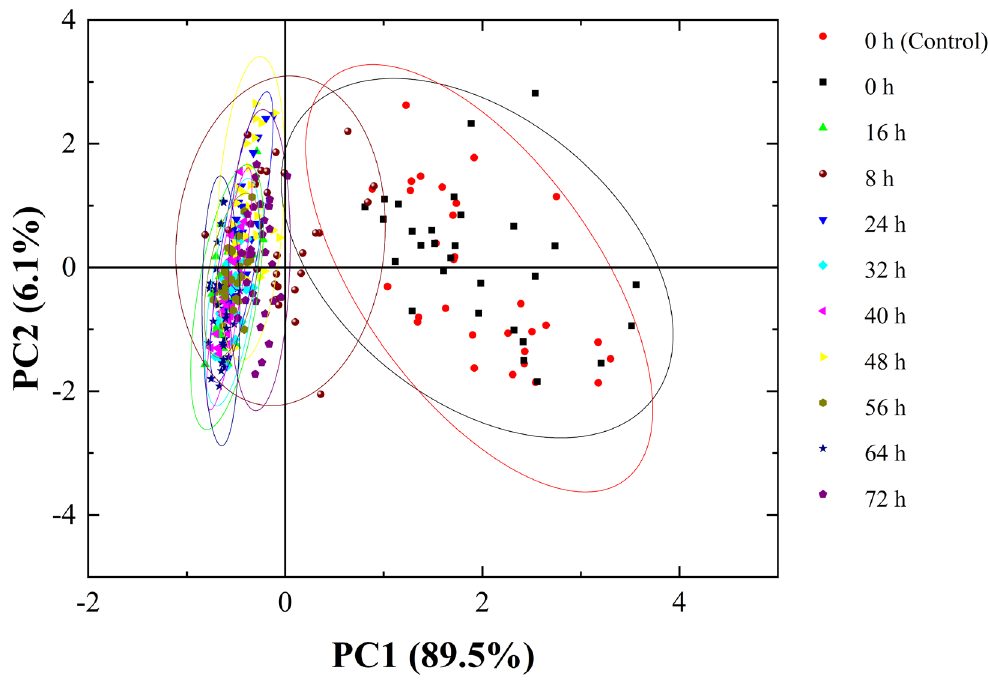
Figure 8. PCA results for the C. fimbriata -infected group and the control group from 0 to 72 h. E-nose data for C. fimbriata -infected sweetpotatoes at 0 h, 48 h, 64 h, and 72 h were used for discrimination. The division of the data sets referred to the method of Li et al. [51]; 70% of the data was selected as the calibration set and 30% as the prediction set. The higher the sensitivity, specificity, precision, and accuracy of the models, the better the